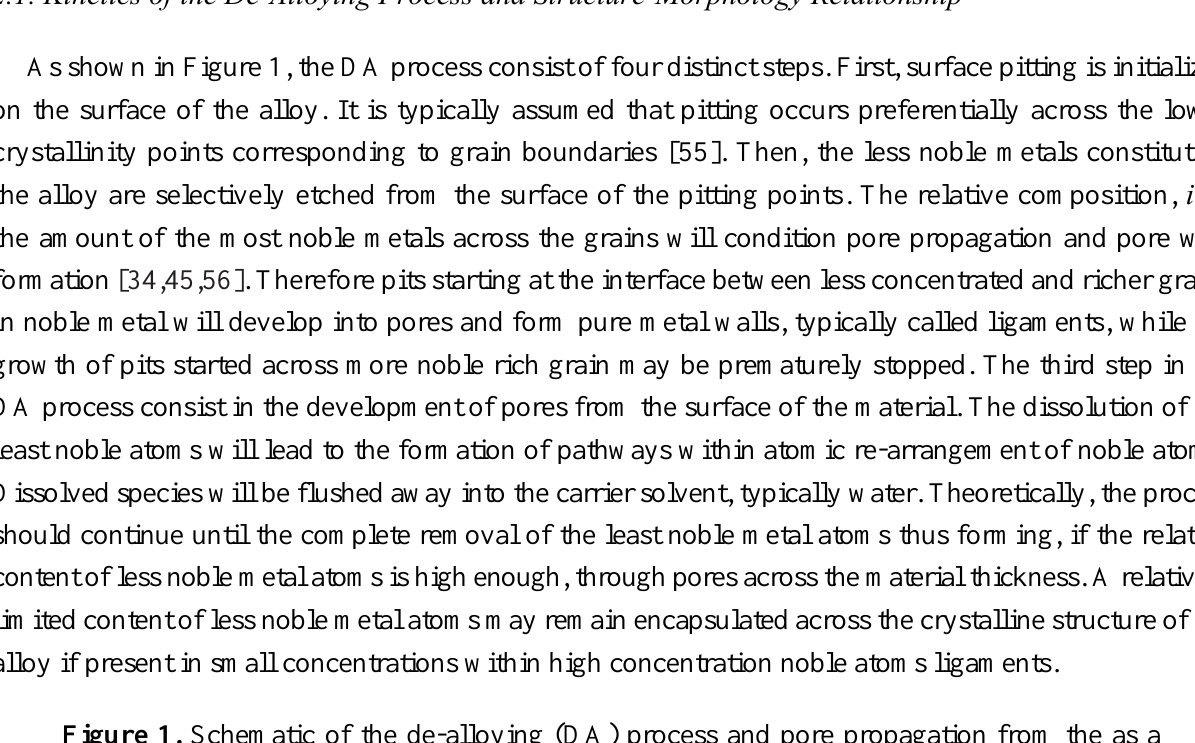
Figure 1. Schematic of the de-alloying (DA) process and pore propagation from the as a function of the grain distribution and composition: ( a ) pristine alloy microstructure with two alloy constituents distributed and mixed across a number of grains; ( b ) surface pitting and pore initiation; ( c ) DA of less noble atom rich exposed grains; ( d ) pore progression and through pore formation; and ( e ) final nano-porous materials. LNC: less noble